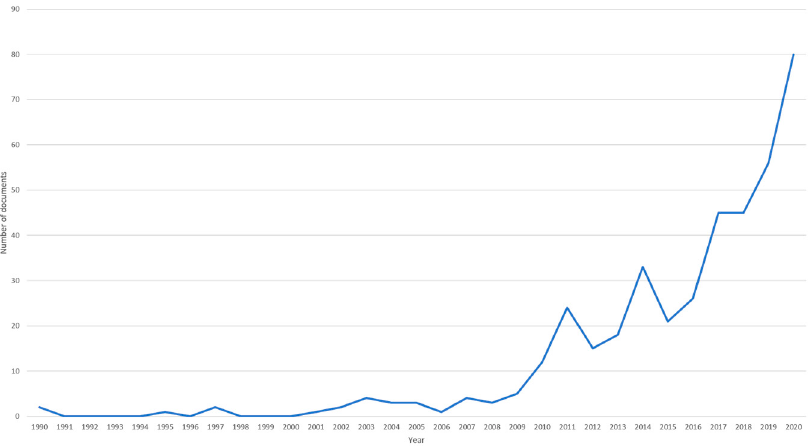
Figure 10. Documents by year for cosmetics (Appendix B—ix).